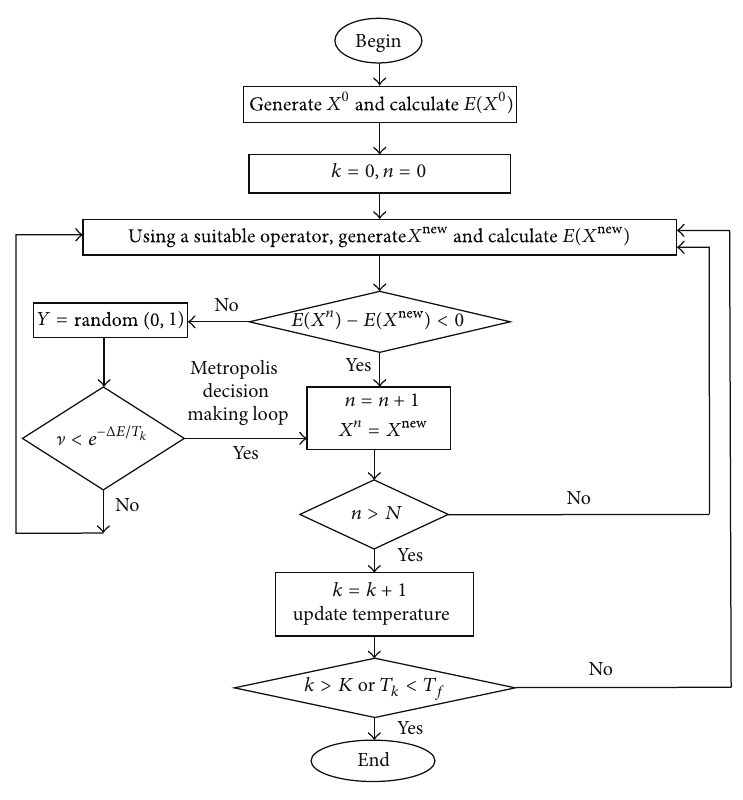
Figure 4: Simulated annealing flowchart.